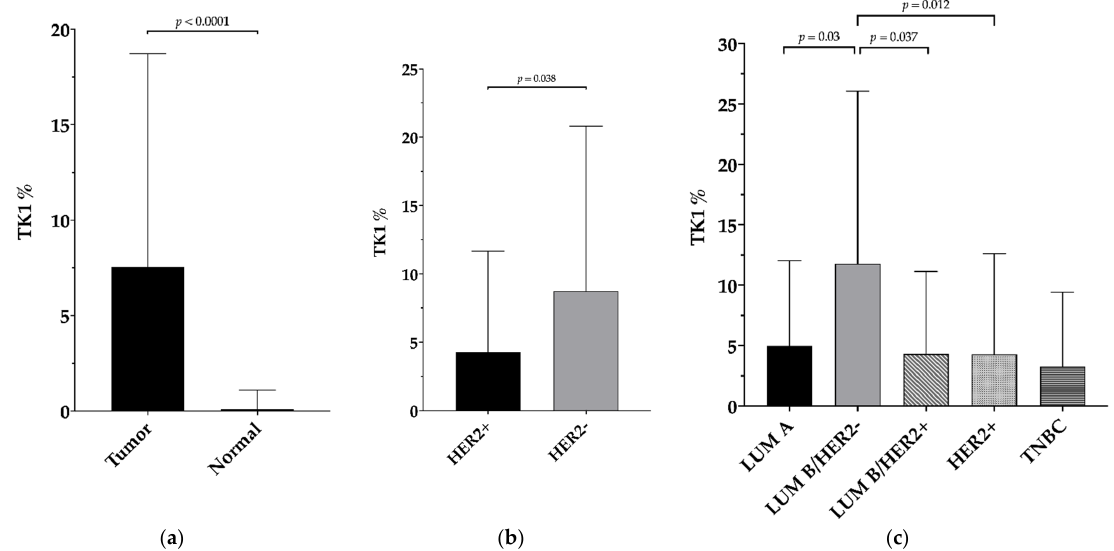
Figure 2. TK1 expression and its association with clinicopathological findings: ( a ) TK1 is significantly overexpressed in BC samples ( p < 0.0001); ( b ) TK1 expression is lower in BC samples with HER2 overexpression/amplification ( p = 0.038); ( c ) Luminal B (HER2-) is the BC molecular subtype with the highest TK1 levels (LUM-B/HER2- vs. LUM-A: p = 0.003; LUM-B/HER2- vs. LUM-B/HER2+ p = 0.037; LUM-B/HER2- vs. HER2+ p = 0.012).